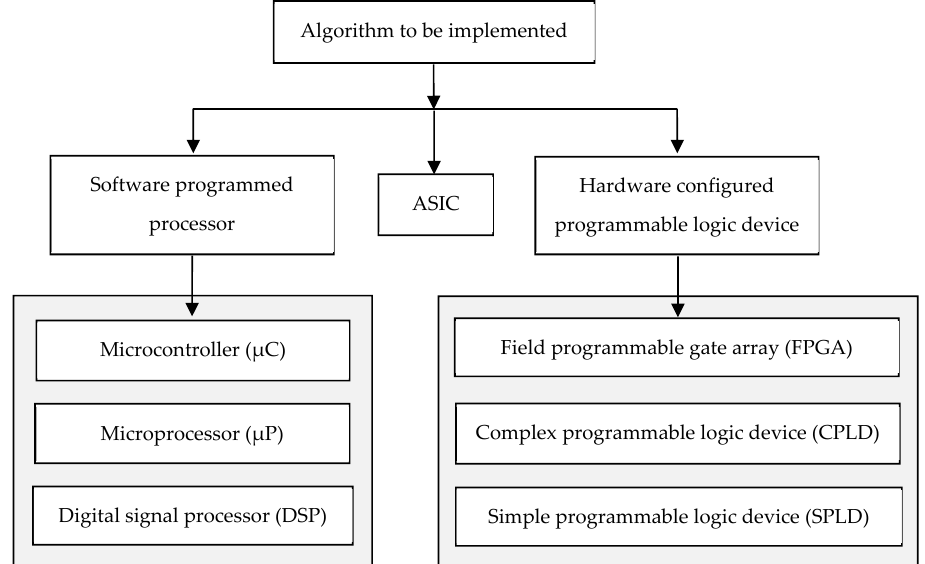
Figure 1. Programmable/configurable device choices for implementing digital signal processing operations in hardware and software.